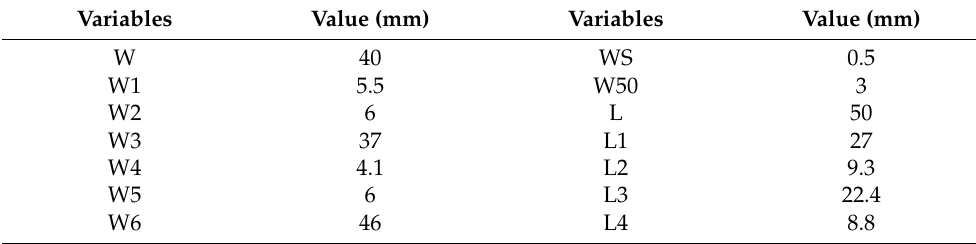
Table 1. Dimensional parameters of the proposed sensor.